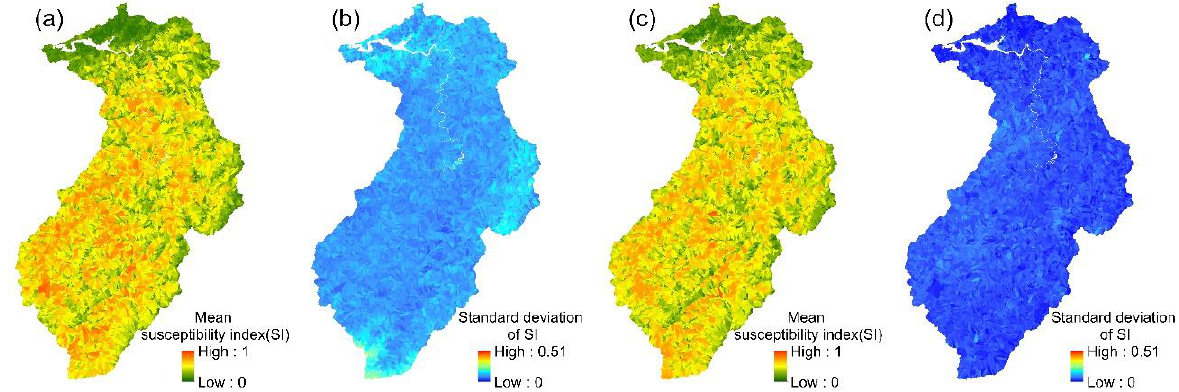
Figure 9. PM ensemble models: ( a , b ) the mean susceptibility index and standard deviation of 24 event-based models; ( c , d ) the mean susceptibility index and standard deviation of the multi-year model.